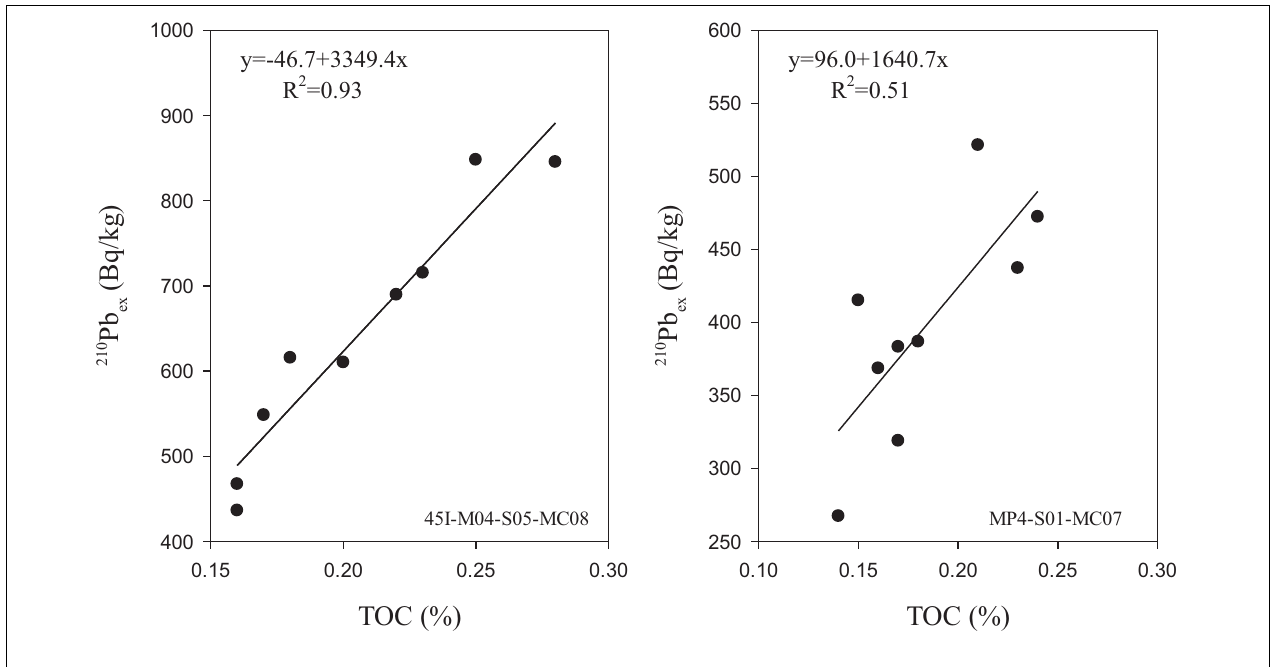
FIGURE 4 | The relationship between 210 Pb ex and